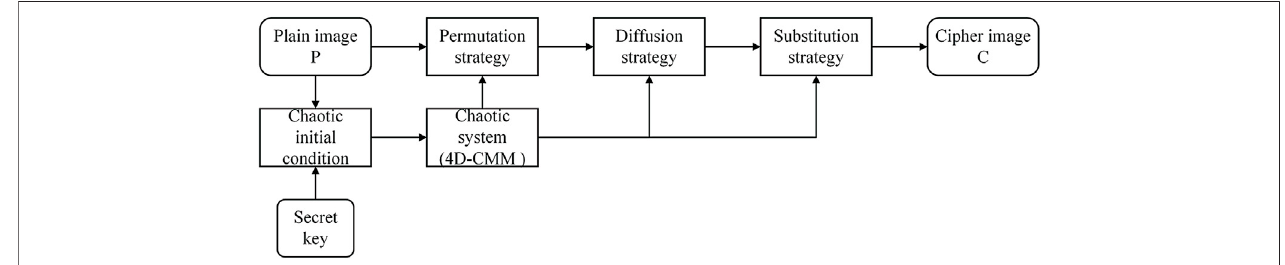
FIGURE 2 | Proposed encryption scheme fl ow chart.